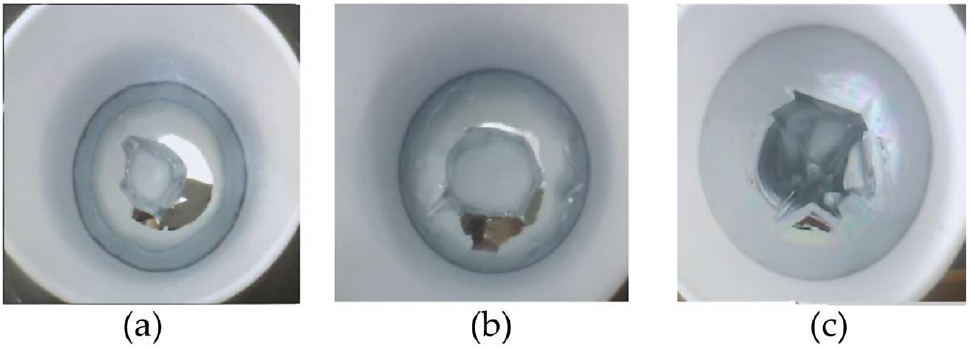
Figure 2. Shape of the solidification at different flow rates: ( a ) 20 L/h; ( b ) 40 L/h; and ( c ) 60 L/h in the refining process.